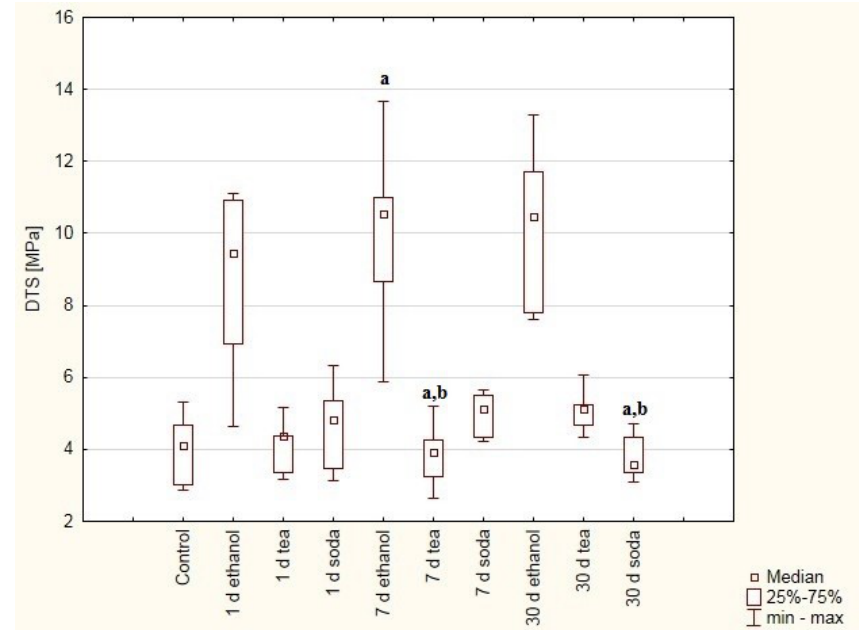
Figure 4. Box and whiskers plot of diametral tensile strength (DTS). Values were obtained for samples made of Adhesor Carbonfine cement treated with ethanol (75%), green tea and baking soda (2.5%) solutions after one, seven or 30 days and samples immersed for seven days in distilled water as control. Statistically significant differences were detected between: (a) 7 days in ethanol solution vs. 30 days in soda solution, 7 days in tea solution, (b) 30 days in tea solution vs. 30 days in soda solution, 7 days in tea solution.